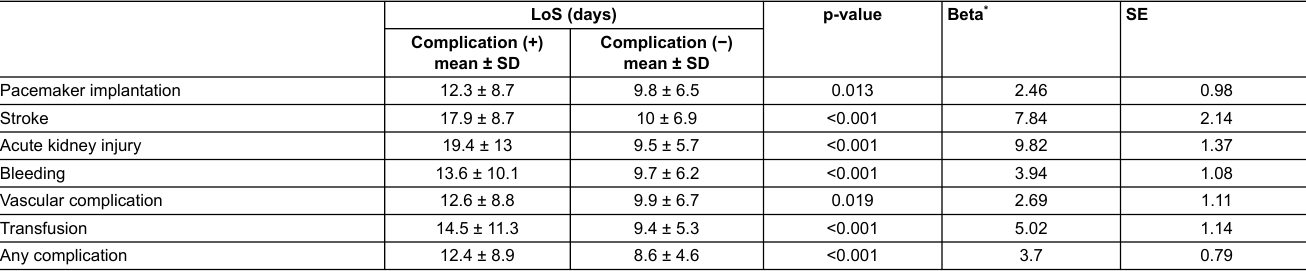
Table 3: Periprocedural complications and hospital length of